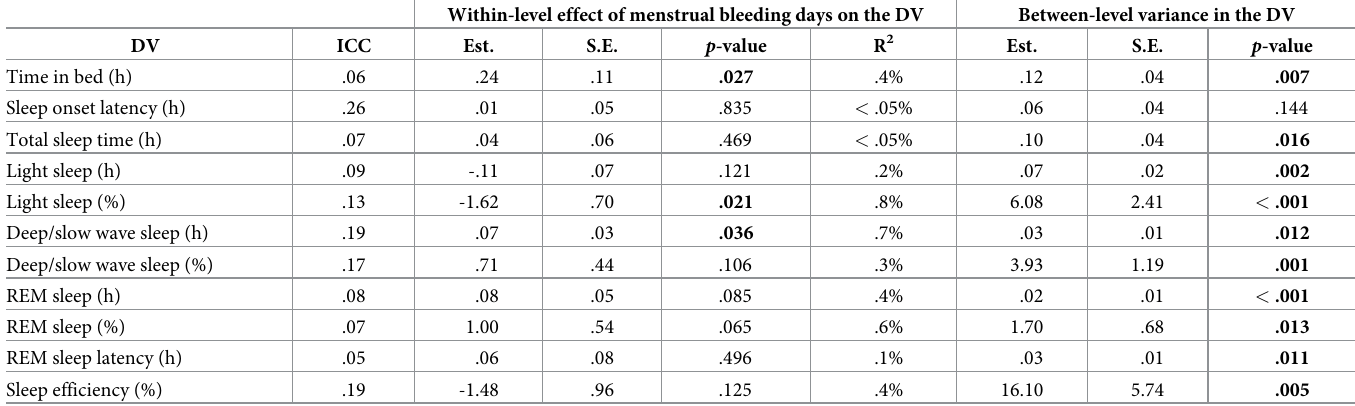
REM = rapid eye movement; DV = dependent variable; ICC = intra-class correlation; Est. = estimate; S.E. = standard error; R 2 = explained variance in %. Regressions were clustered on participant. Values are unstandardized. Significant results are highlighted in